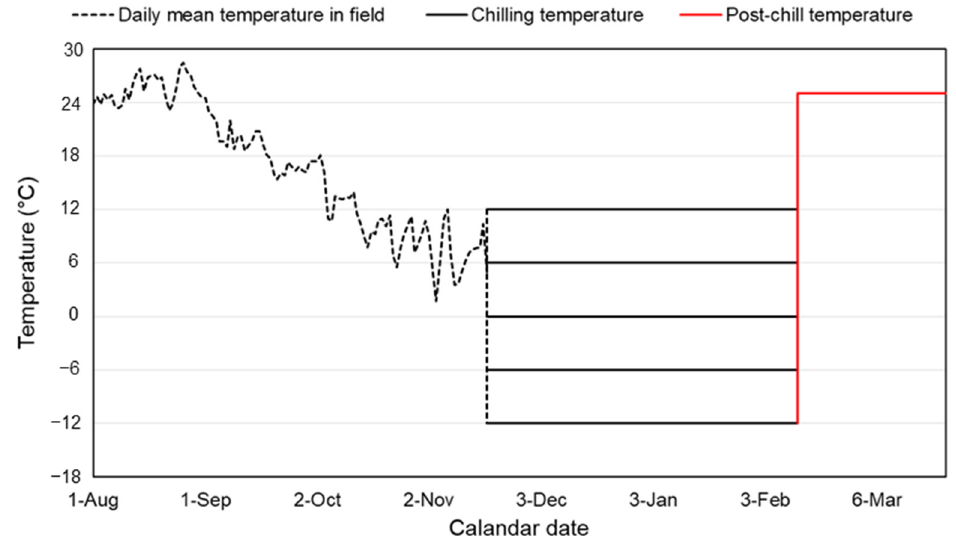
Figure 2. Schematic diagram of temporal pattern of temperature experienced by eggs of HC popu- lation in this study. Daily mean temperatures before the date of egg collection were obtained from KMA website (http://web.kma.go.kr/, accessed on 31 October 2022). The eggs were exposed to one of the five chilling tempera ‐ tures ( − 12, − 6, 0, 6, and 12 °C) for 100 days, followed by post ‐ chill temperature of 25 °C.